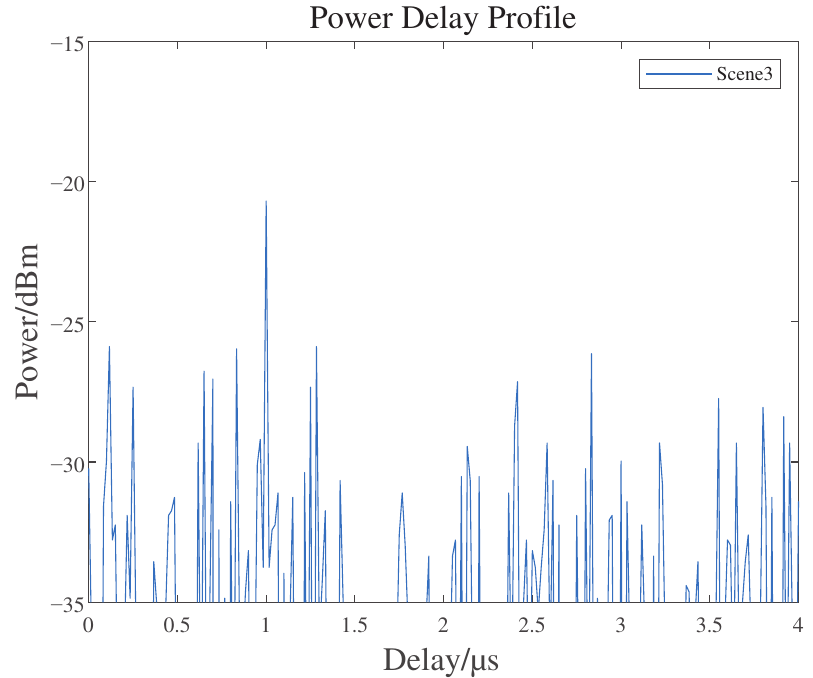
Figure 11. Channel sounding PDP of scene 3.